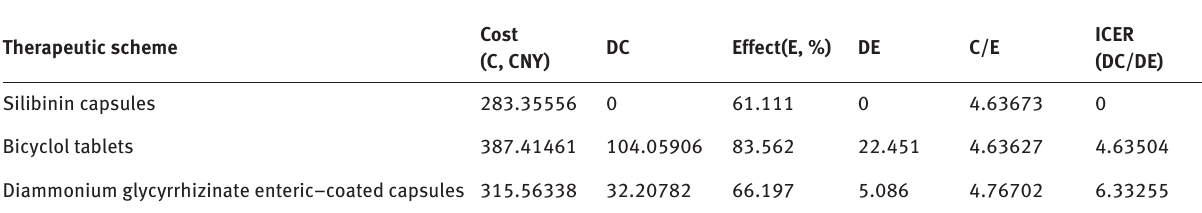
Table 5: Cost-effectiveness analysis of three groups based on the rate of complete normalization